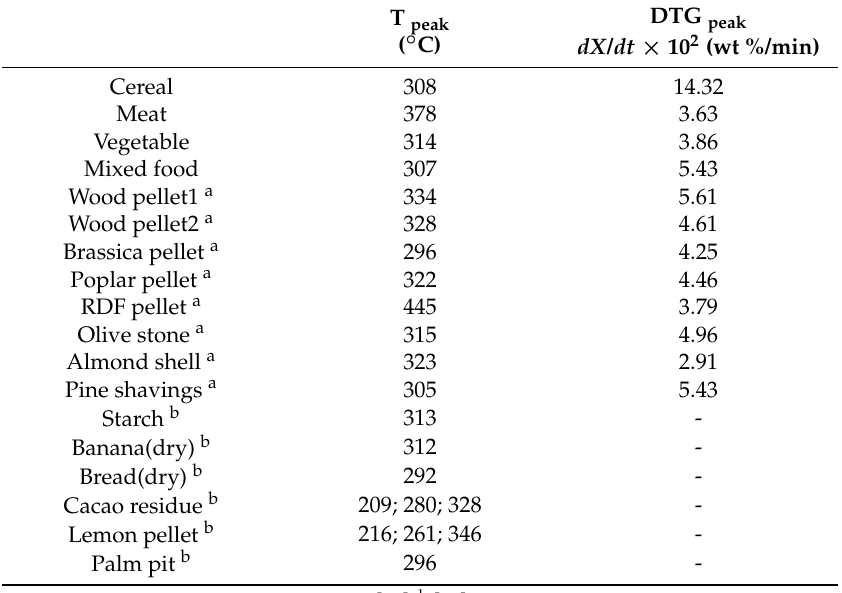
Table 3. Analyzed food waste and organic materials and DTG peak